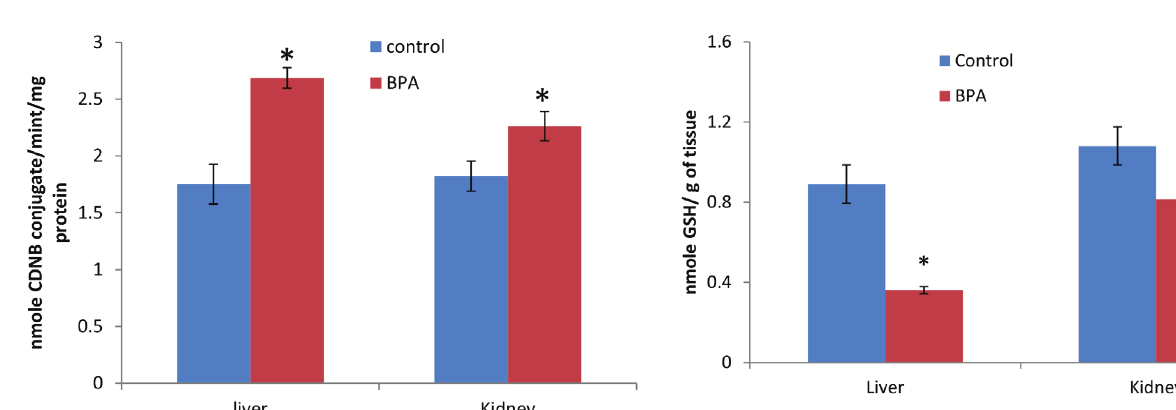
FIGURE 6 - Reduced glutathione content in the liver and kidneys of C. idella (n=5), exposed to the sublethal concentration of BPA for 14 days. The values give are mean ±S.E.M. * = p<